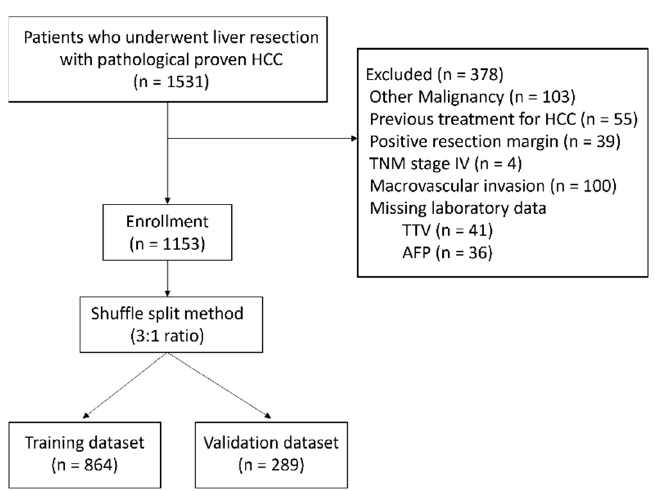
Figure 1. The CONSORT flow diagram of the enrollment of patients and the random split.